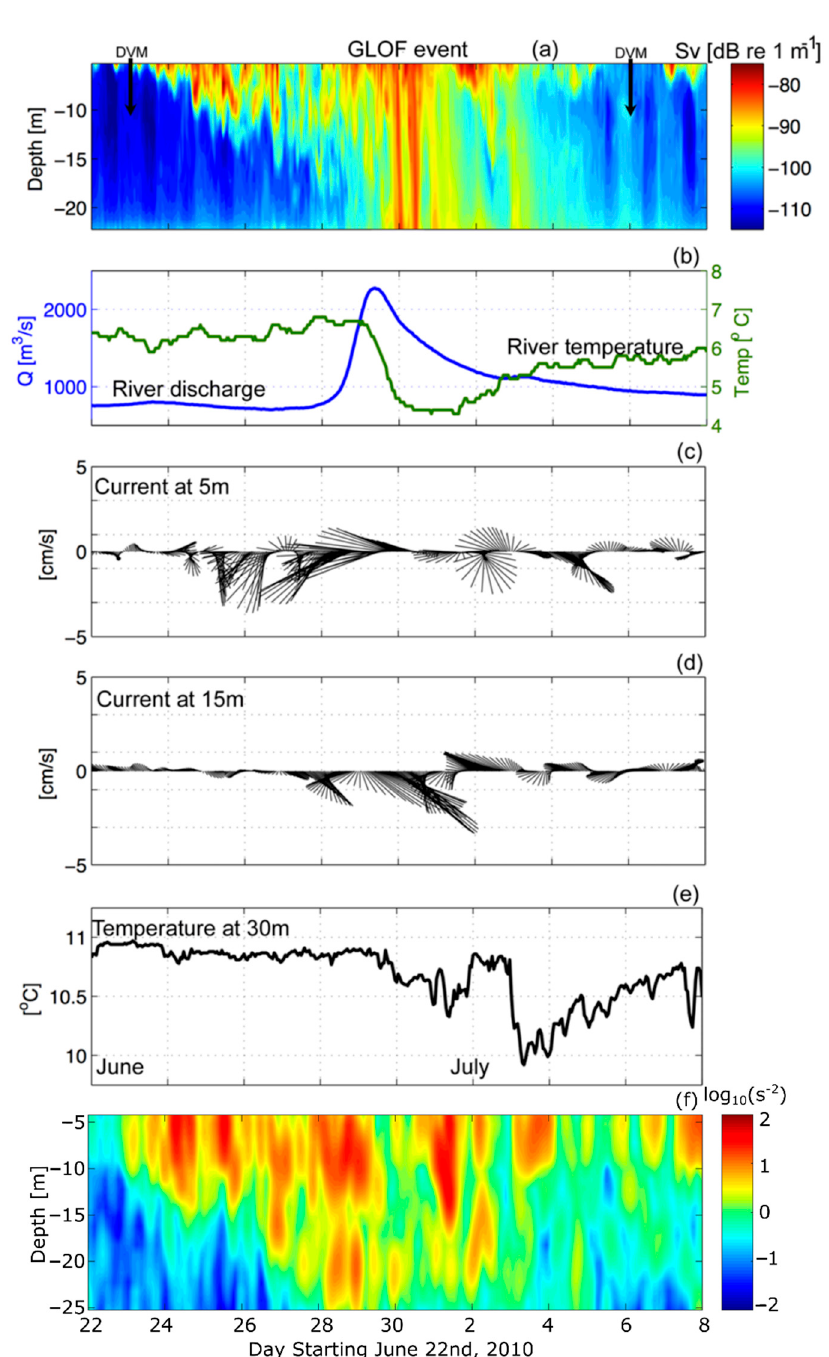
Figure 6. ( a ) S v during the GLOF II event. ( b ) Baker River discharge values and temperature measurements collected at the same location as river discharge measurements ( ◦ C). ( c ) Vectors of the horizontal velocity components collected from the ADCP (cm s − 1 ) at 5 m depth. ( d ) Same as ( c ) for 15 m depth. ( e ) Temperature measured from the ADCP ( ◦ C) at 30 m depth. ( f ) Squared vertical shear (log 10 (s − 2 )).